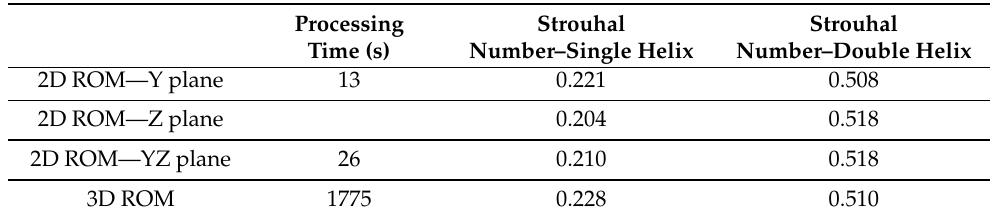
Figure 6. Axial component ( m / s ) of the single and double helix using 3D and 2D ROM. The top four pictures correspond to the single helix with Strouhal numbers of 0.228 and 0.210 for the 3D and 2D ROM, respectively. The bottom four pictures correspond to the double helix with Strouhal numbers of 0.510 and 0.518 for the 3D and 2D ROM, respectively. The first two columns show the two modes obtained from 3D ROM, whereas the last two columns correspond to the 2D ROM. Table 2. Processing time and Strouhal numbers of single and double helices of different input datasets for